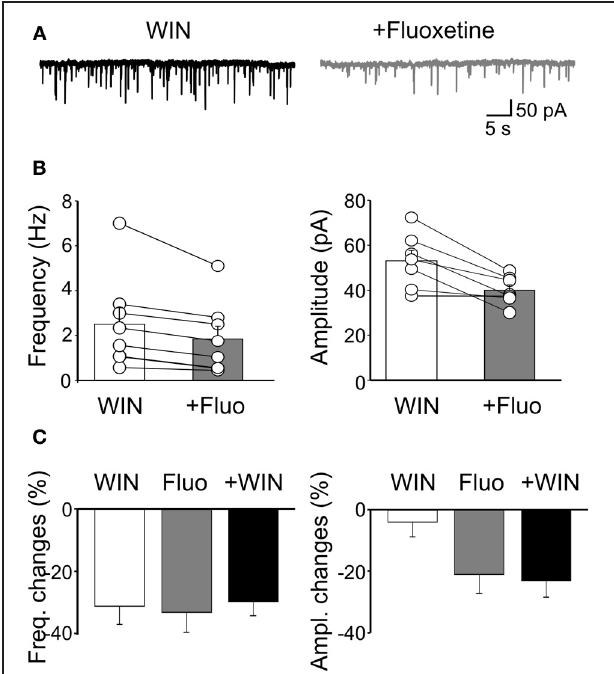
FIGURE 7 | Fluoxetine-induced reduction of sGPSCs frequency and amplitude does not involve CB1 receptor-positive GABAergic interneurons. (A) Sample traces of sGPSCs recorded in the presence of WIN55,212-2 (1 μ M) and WIN55,212-2 plus fluoxetine (20 μ M). (B) Summary plots of the mean frequency ( n = 8; p = 0 . 008) and amplitude ( n = 7; p = 0 . 008) of sGPSCs recorded in the presence of WIN55,212-2 (white columns) and WIN55,212-2 plus fluoxetine (gray columns) for all cells tested ( ± SEM). (C) Frequency and amplitude changes (as percentage of controls) induced by bath application of WIN55,212-2 (white), by fluoxetine (grey) and fluoxetine plus WIN55,212-2 (black). Note that while WIN55,212-2 depressed only the frequency of sGPSCs, fluoxetine depressed both the frequency and the amplitude. In addition, fluoxetine depressed to a similar extent the amplitude and the frequency of sGPSCs when applied alone or in the presence of WIN55,212-2.